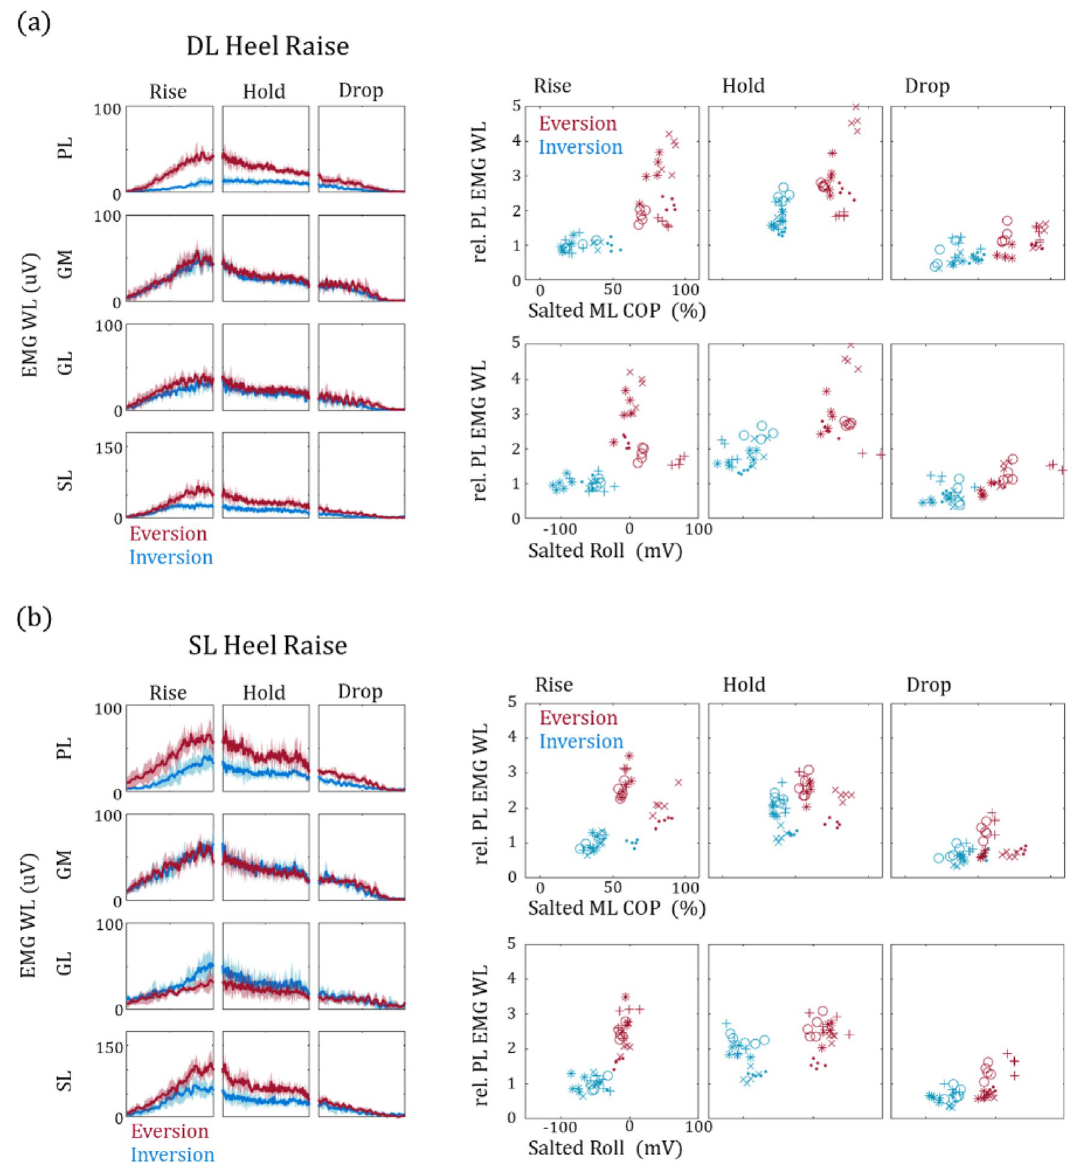
Figure 5. Analysis of EMG signals during heel raise. EMG data acquired from PL, GM, GL and SL during double and single leg heel raise are shown in ( a ) and ( b ), respectively. The data clearly show an increase of PL activation, during the concentric rise phase, with ankle eversion (red lines) compared to inversion (blue lines). Data from all five subjects are shown in the right panels. Because the EMG signals from different subjects cannot be directly compared, the data points are represented as relative EMG WL normalized against the mean from the respective subjects during the rise phase. The data show that ankle eversion clearly elicits an increase in PL activation during the rise